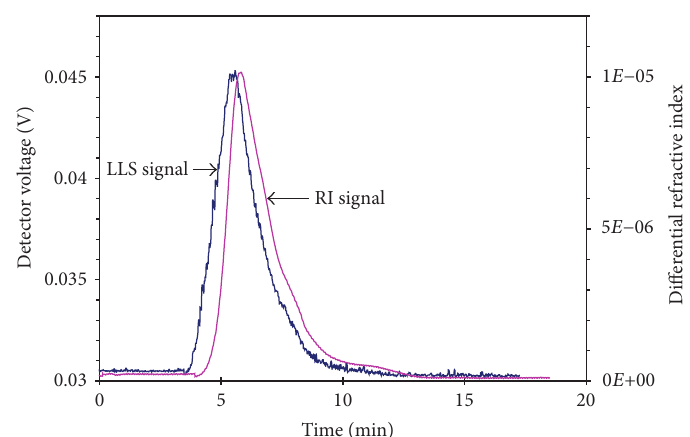
F 2: e eluent chromatograms of Molecular weigh of KGM by GPC-LLS-RI.